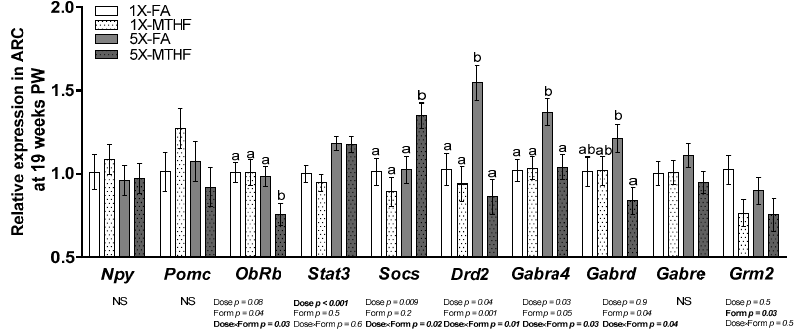
Figure 4. Relative mRNA expression of energy regulatory genes in the arcuate nucleus of the hypothalamus (ARC) of offspring at 19 weeks post-weaning (PW). n = 6–7/group. Values are least square Means ± standard error of the mean (S.E.M.). Analyzed by two-way ANOVA with Dose (1X or 5X) and Form (FA vs. MTHF) as main factors and a Dose×Form interaction term. Different letters (a,b) indicate significant differences at p < 0.05 by Tukey’s post-hoc analysis. Values in bold indicate significant effects. Abbreviations: AIN-93G rodent diet with either 1X-FA, recommended folic acid (2 mg/kg diet); 5X-FA (10 mg/kg diet); 1X-MTHF, equimolar recommended [6S]-5-methyltetrahydrofolic acid calcium salt (2.1 mg/kg diet); or 5X-MTHF (10.4 mg/kg diet). Npy , neuropeptide Y; Pomc , pro-opiomelacortin; ObRb , leptin receptor long isoform; Stat3 , signal transducer and activator of transcription 3; Socs3 , suppressor of cytokine signaling-3; Drd2 , dopamine receptor type 2; Gabra4 , gamma-aminobutyric acid type A receptor ( Gabr ) subunit 4alpha; Gabrd , Gabr subunit delta; Gabre , Gabr subunit epsilon; Grm2 , glutamate receptor 2; NS, non-significant.